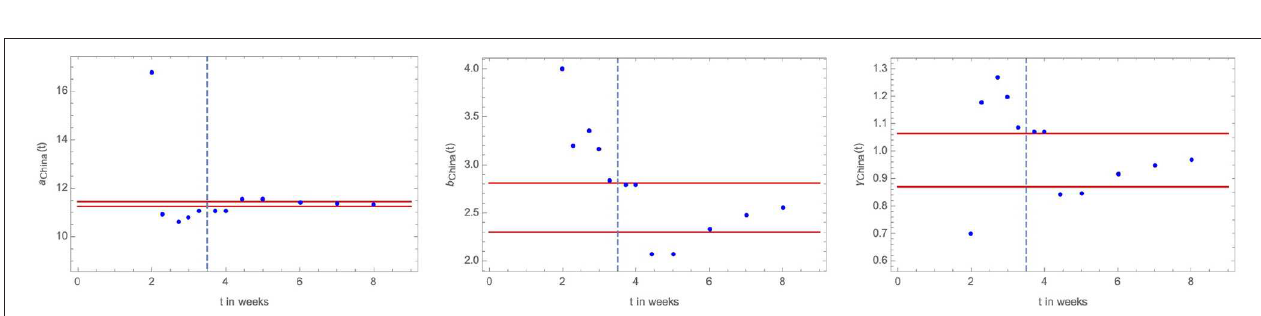
FIGURE 4 | (Left) COVID-19 infected cases in China as function of the week number starting from January 21st 2019. In red, we report the exponential of the epidemic strength model result. (Right) Epidemic strength (the logarithm of the number of infected cases) and the best fit result as in Equation (5).